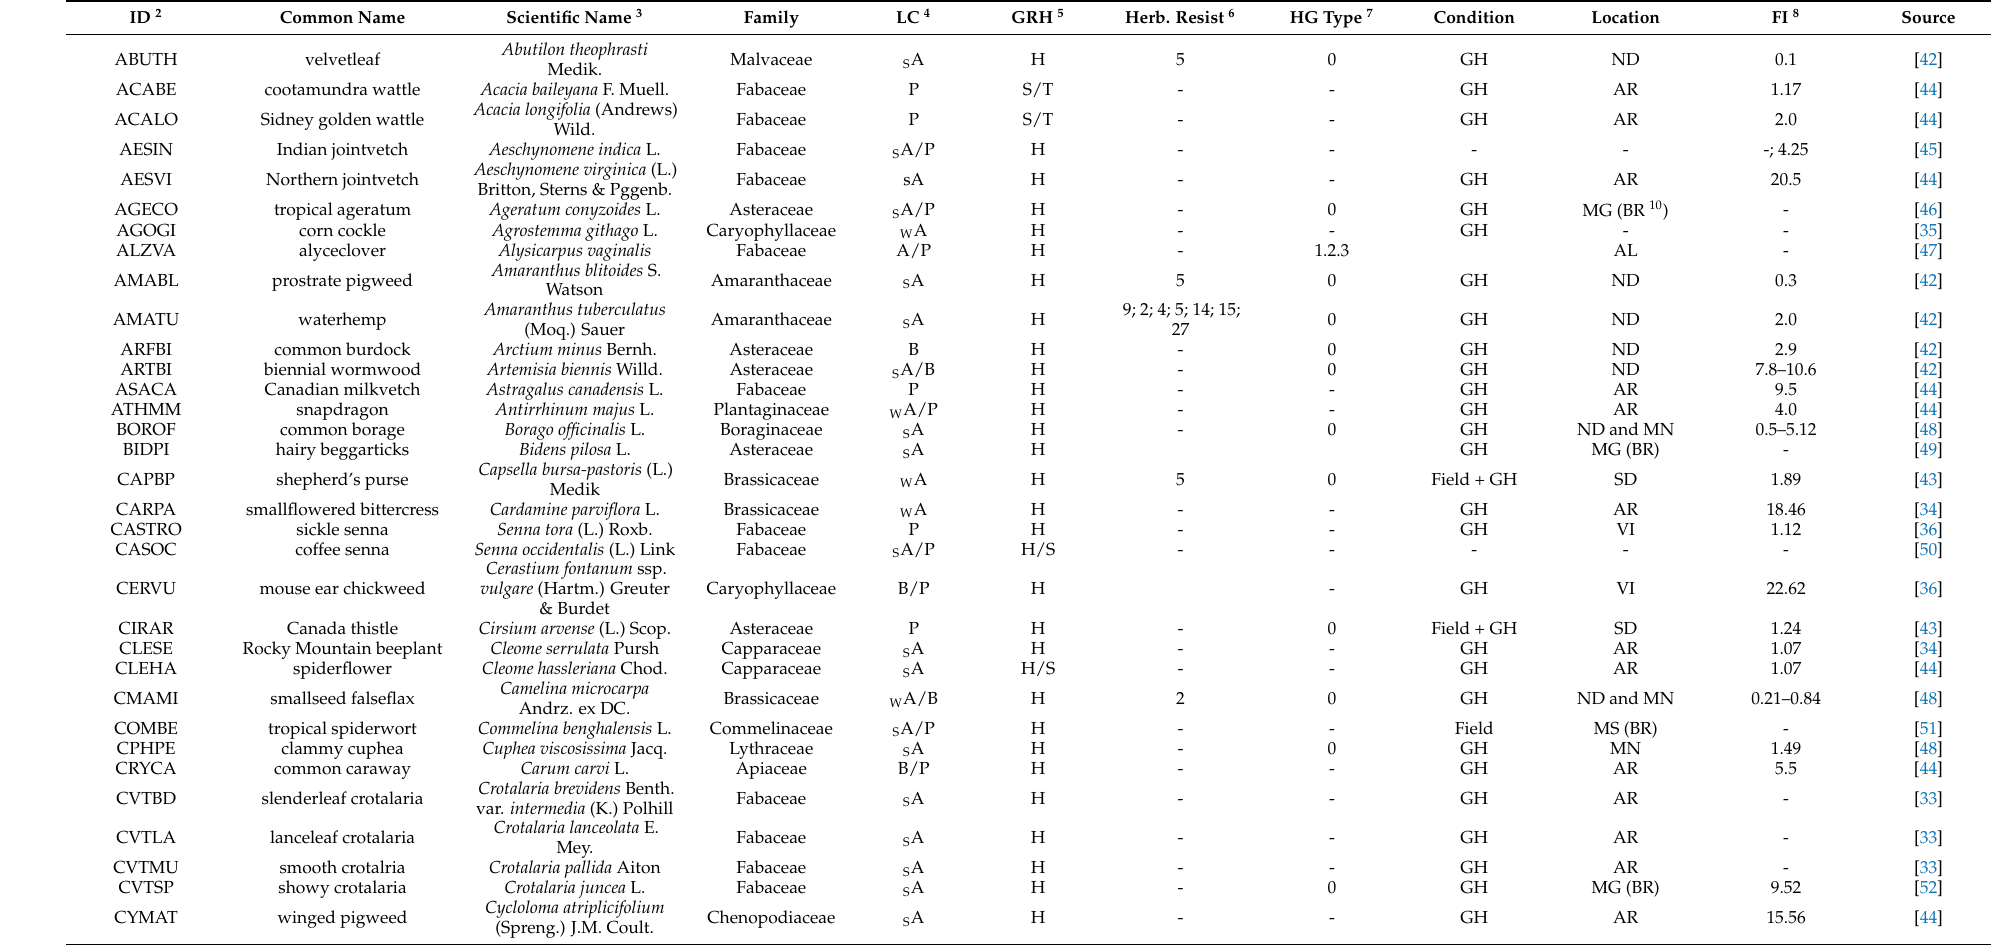
Table 1. Weed species 1 reported as hosts of SCN, with respective botanic classifications, life cycle (LC), growth habit (GRH), herbicide resistance cases, HG ( Heterodera glycines ) types 7 , location, and female